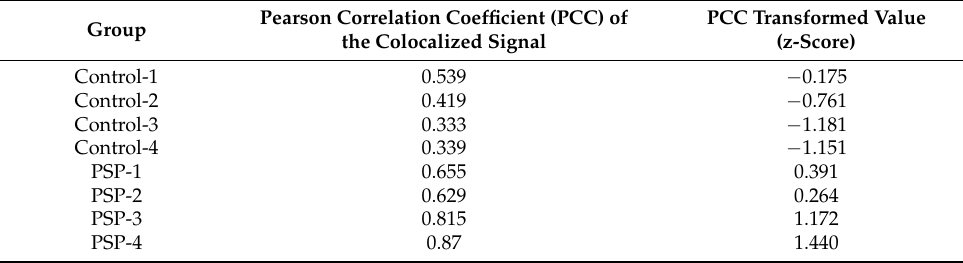
PCC Transformed Value (z-Score)